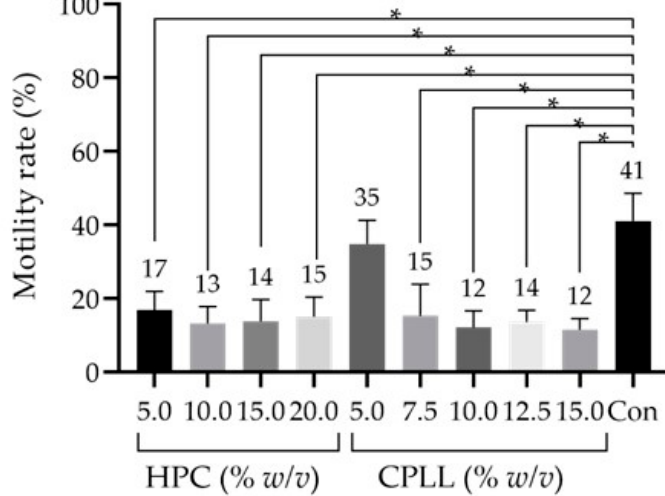
Figure 1. Sperm motility rates after freeze–thawing with cryopreservation reagents containing macro-molecular-weight (Mw) cryoprotective agents (CPAs) at different concentrations. Hydroxypropyl cellulose (HPC), 5.0–20.0% w / v . Carboxylated poly- L -lysine (CPLL), 5.0–15.0% w / v . The low-